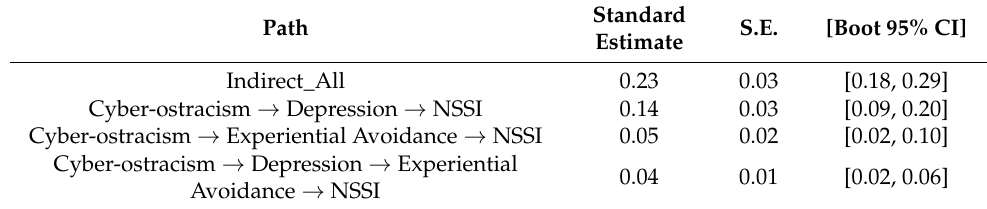
Figure 2. The mediation model. Note: *** p < 0.001. The results of the bootstrap test indicated that depression and experiential avoidance mediated the relationship between cyber-ostracism and NSSI (see Table 2). Specifically, through three pathways, one through the indirect role of depression (indirect effect = 0.14, SE = 0.03, 95%CI = [0.09, 0.20]) accounted for 60.87% of the total indirect effect. One through the indirect role of experiential avoidance (indirect effect = 0.05, SE = 0.02, 95%CI = [0.02, 0.10]) accounted for 21.73% of the total indirect effect. A chain mediating role through depression and experiential avoidance (indirect effect = 0.04, SE = 0.01, 95%CI = [0.02, 0.06]) accounted for 17.40% of the total indirect effect. Table 2. Bootstrap test of path.